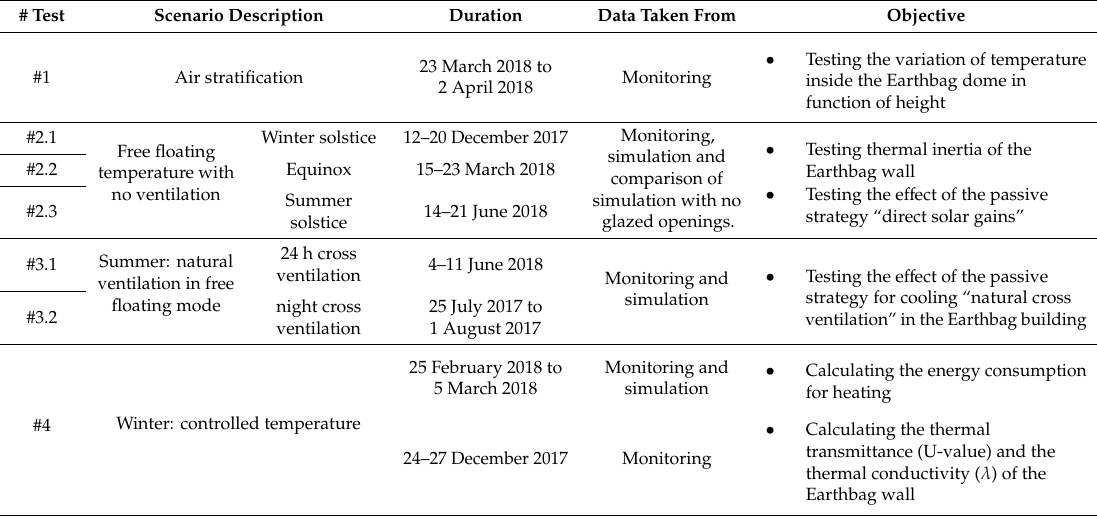
Table 2. Testing scenarios of monitoring and simulation of the Earthbag